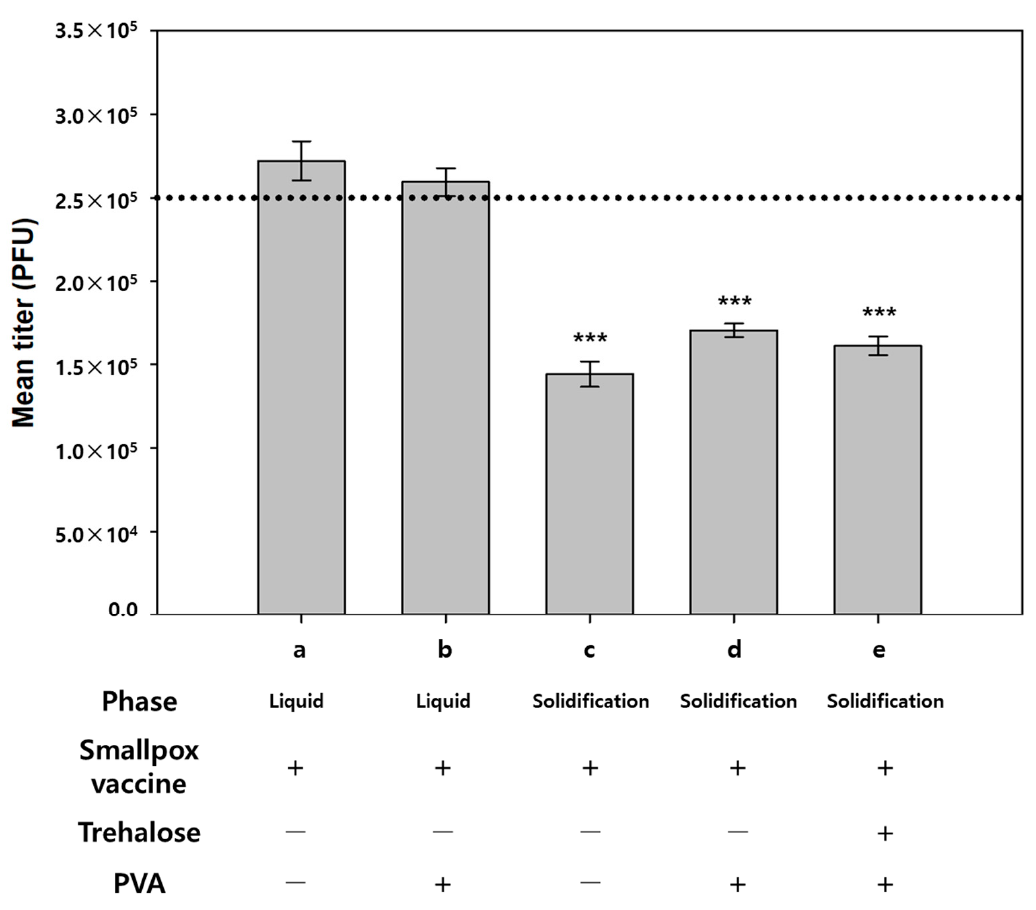
Figure 2. Virus titers of ( a ) smallpox vaccine (F1) (liquid), ( b ) smallpox vaccine + polyvinyl alcohol (F2) (PVA; liquid), ( c ) smallpox vaccine (F1) (reconstituted after solidification), ( d ) smallpox vaccine + PVA (F2) (reconstituted after solidification), and ( e ) smallpox vaccine + PVA + trehalose (F4) (reconstituted after solidification). Dotted line indicates the estimated virus titer. Statistical significance compared to liquid smallpox vaccine ( a ) was determined using Student’s t -test (*** p < 0.001).